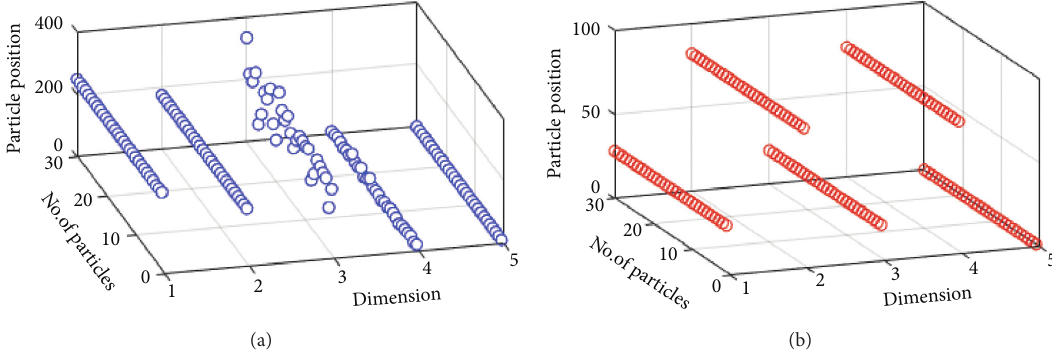
Figure 11: Particle convergence after 100 iterations. (a) PSO. (b) AIWPSO.